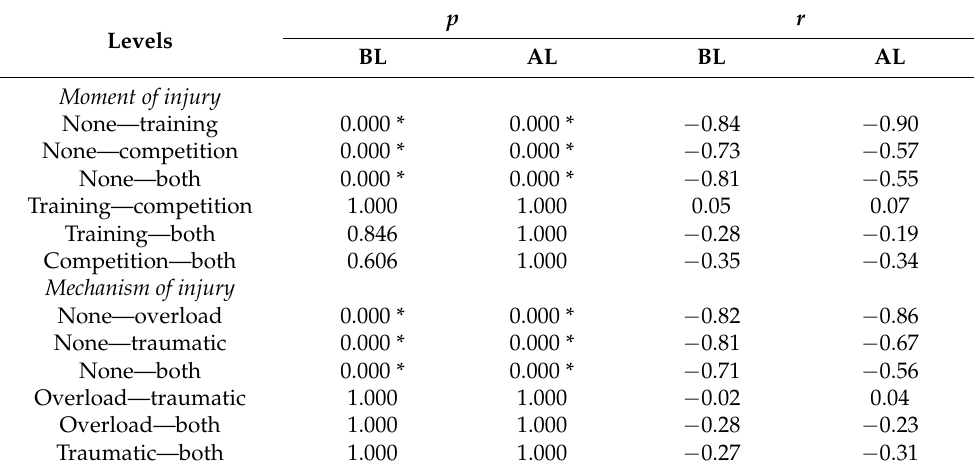
Table 5. Pairwise comparisons for the different levels of the variables ‘moment of injury’ and ‘mechanism of injury’ between BL and AL periods.